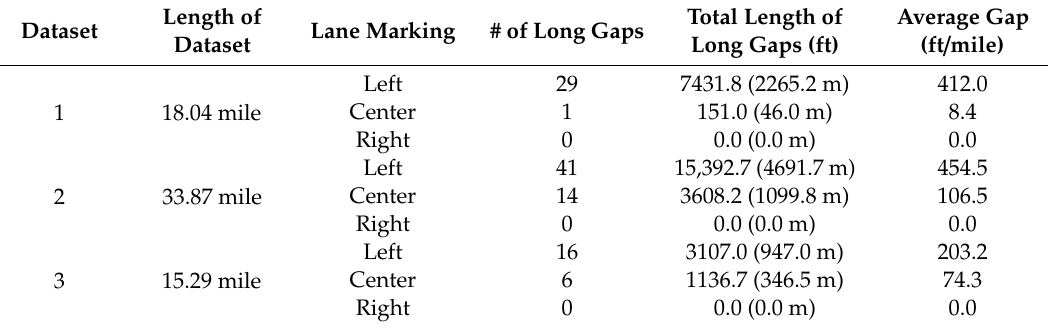
Table 12. Statistics of long lane marking gaps for datasets 1, 2, and